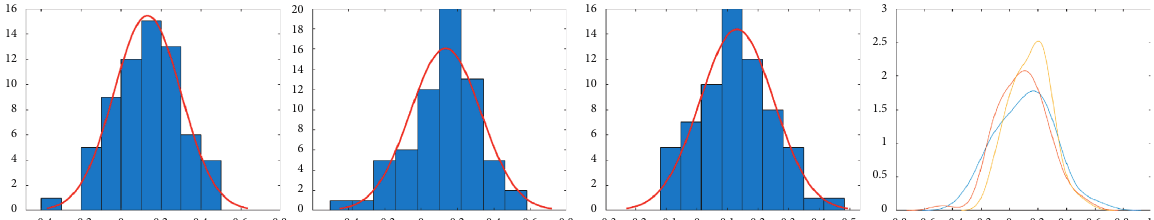
Figure 11: Standard deviation and normal distribution curve of pair 1, pair 2, and pair 3.